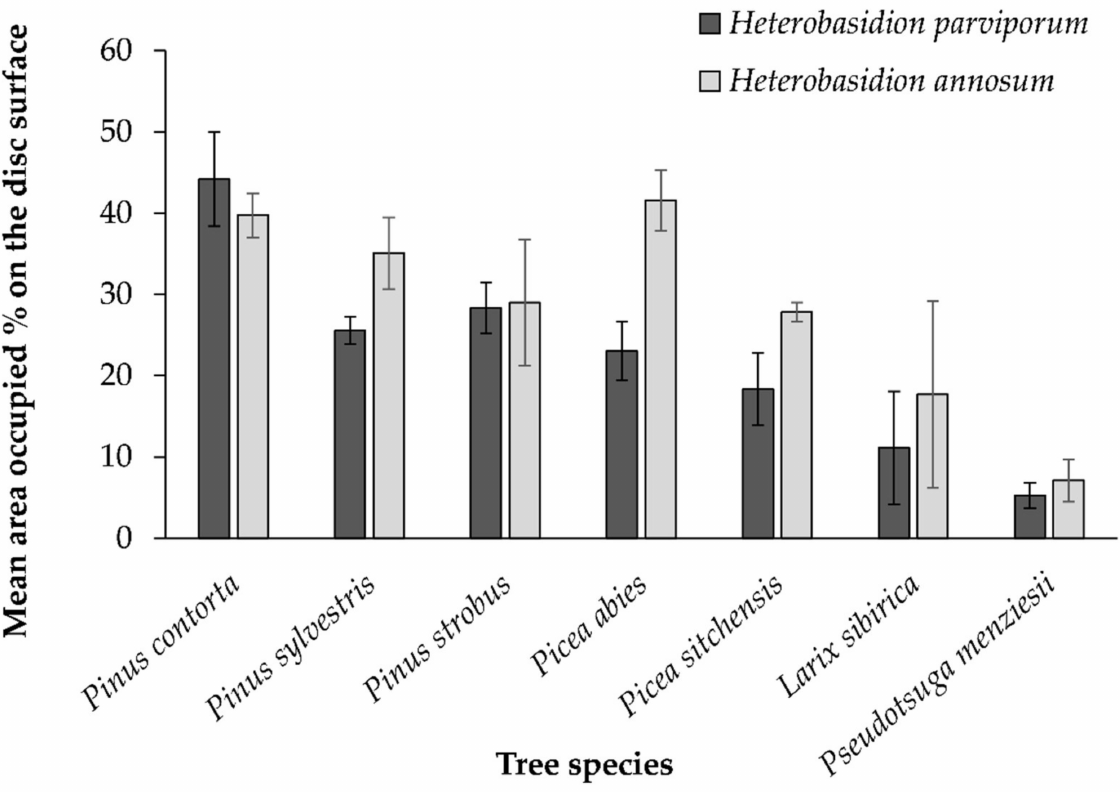
Figure 3. The mean area occupied by Heterobasidion annosum and H. parviporum on wood discs of seven coniferous tree species inoculated with conidial